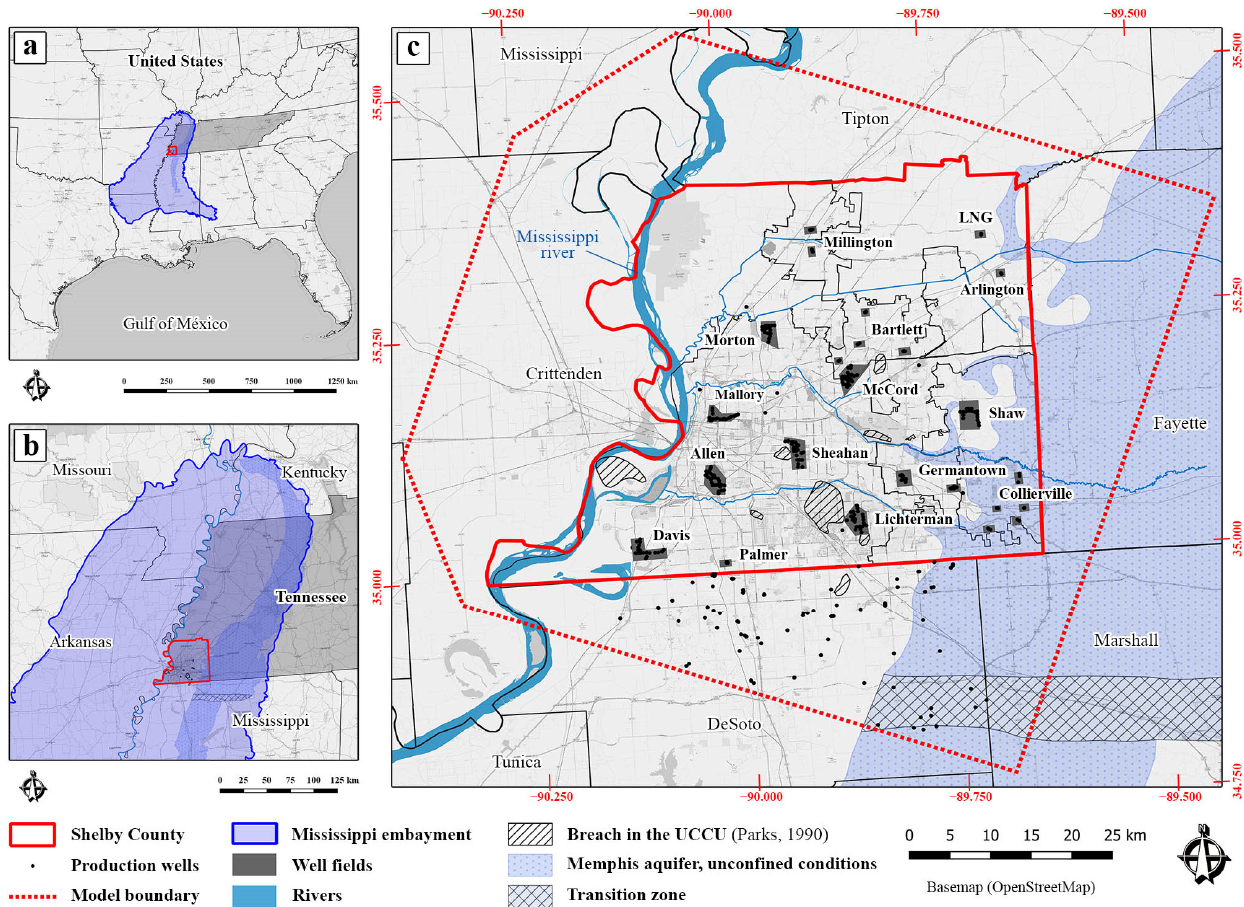
Figure 1. ( a ) Mississippi embayment aquifer system [27] (Figure S1 in the Supplementary Material). ( b ) Location of Shelby County within the Mississippi embayment and the state of Tennessee (Figure S2 in the Supplementary Material). ( c ) Study area showing well fields and production wells screened in the Memphis and Fort Pillow aquifers in this study. Breaches through the upper Claiborne confining unit are also shown as mapped by Parks [4], as well as the area where the Memphis aquifer is under unconfined conditions. The transition zone approximates the area where the middle part of the Memphis aquifer changes from clay-rich (south) to sand-rich (north) [26].